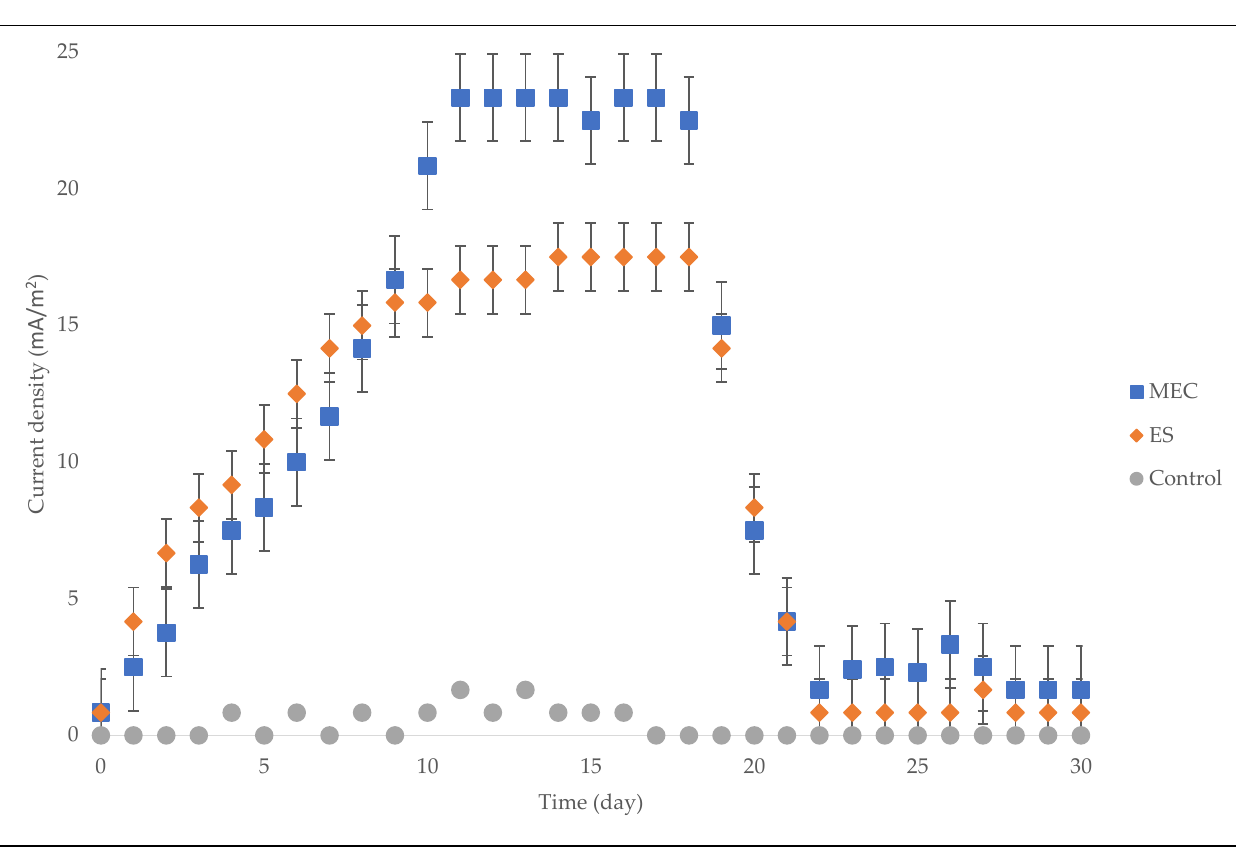
Figure 4. Current density for MEC, ES and control over a period of 30 days.